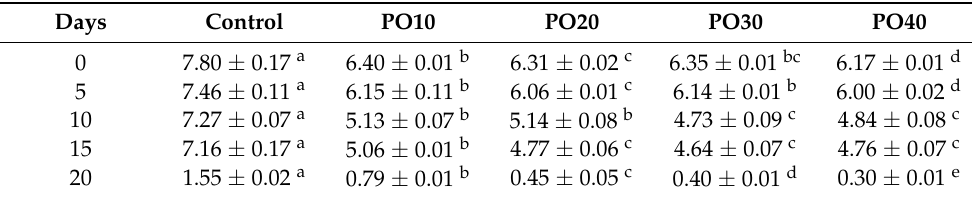
Table 7. Residual nitrite of Pleurotus ostreatus (PO) pork sausages during storage for every group (mg).